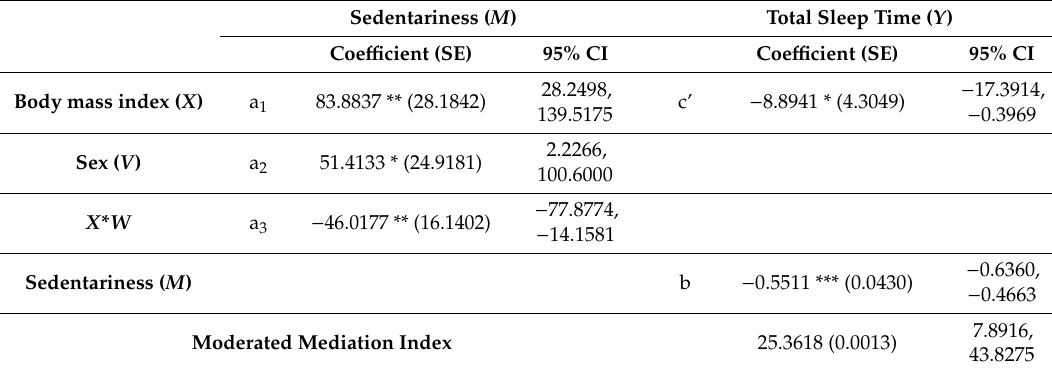
Figure 3. Moderated mediation model of the relationship between body mass index and total sleep time (min) with sedentary time (min) and sex as mediator and moderator variables, respectively. Paths a, b, c, and c’ are presented as unstandardized coe ffi cients (standard error). [Lower-limit confidence interval (CI); upper-limit CI], lower and upper levels for 95% bias-corrected CIs of the indirect e ff ects based on 5000 bootstraps. BMI, body mass index; CI, confidence interval; β (X), unstandardized coe ffi cient of the association of BMI with sedentariness; β (W), unstandardized coe ffi cient of the association of sex with sedentariness; β (X*W), unstandardized coe ffi cient of the association between BMI and sedentariness moderated by sex. Table 2. Unstandardized regression coe ffi cients (standard errors) with confidence intervals of BMI estimating sedentariness and total sleep time including sex as a moderator